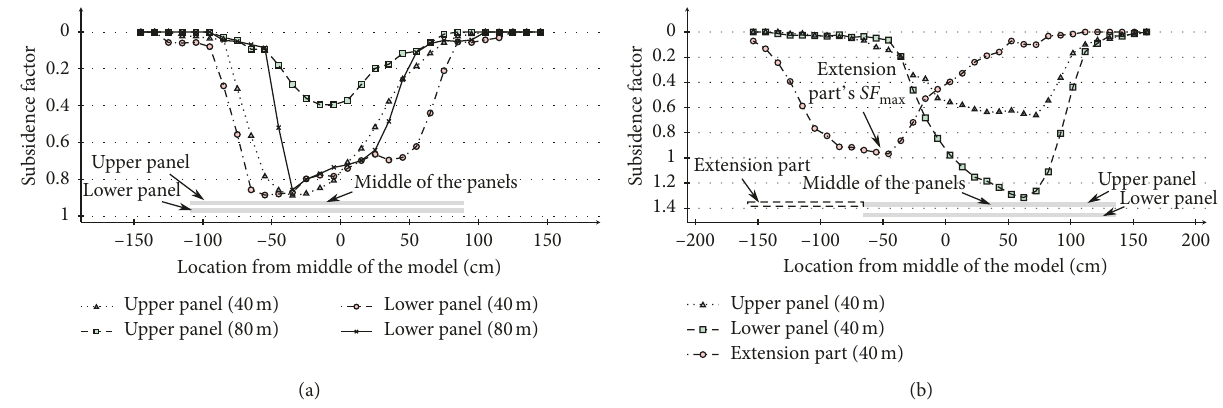
Figure 12: Magnitude of SF after extraction of each panel in (a) Case 1 and (b) Cases 2 and